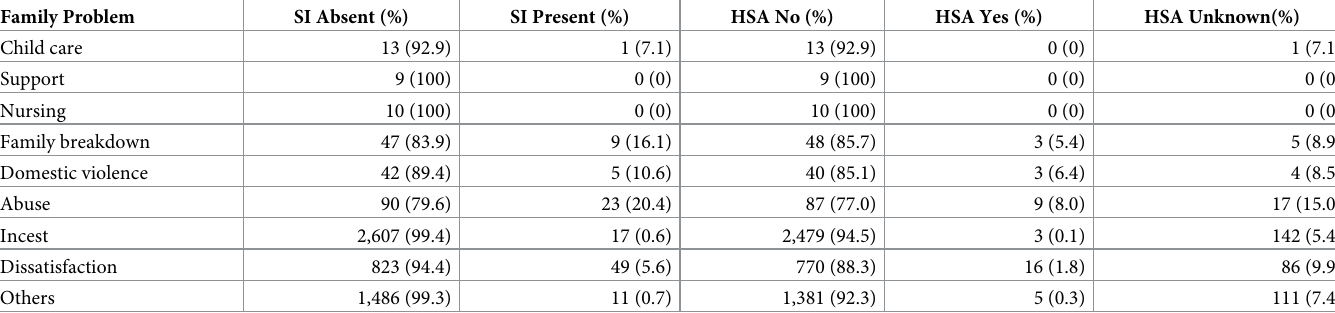
Table 3. Relationship between Family Problems, Suicidal Ideation and History of Suicide Attempts.